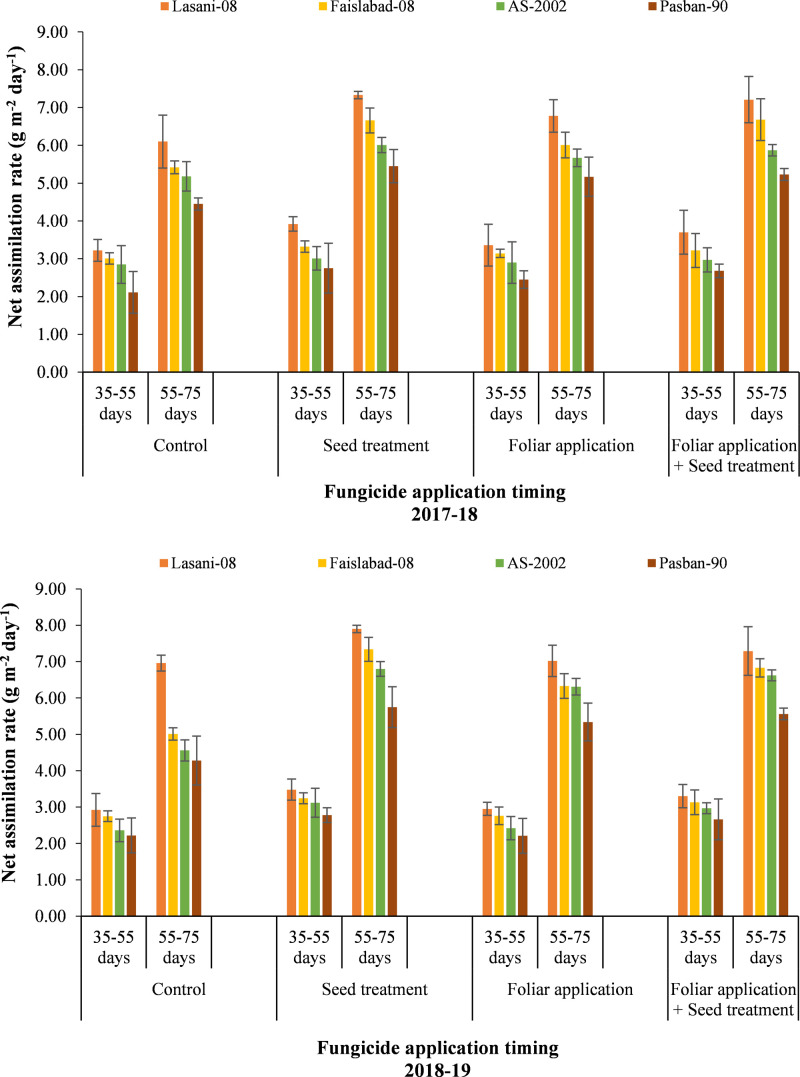
The influence of different fungicide application timings on net assimilation rate of wheat cultivars with varying tolerance to Karnal bunt disease.